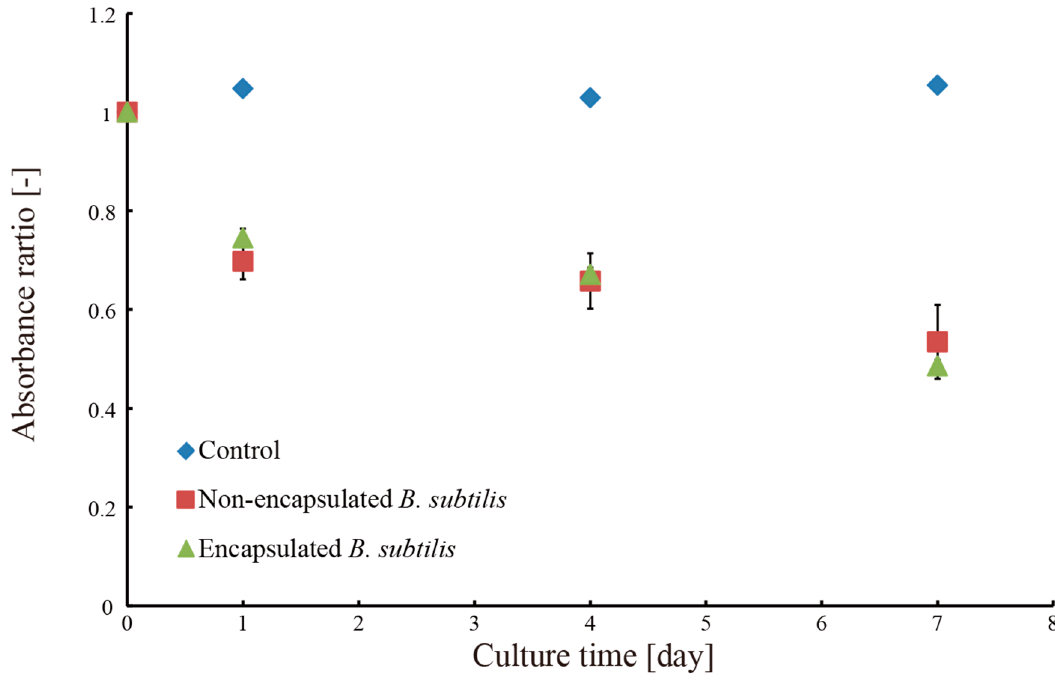
Figure 10. Relationship between the absorbance ratio of methylene blue and culture time with encapsulated and non-encapsulated B. subtilis.